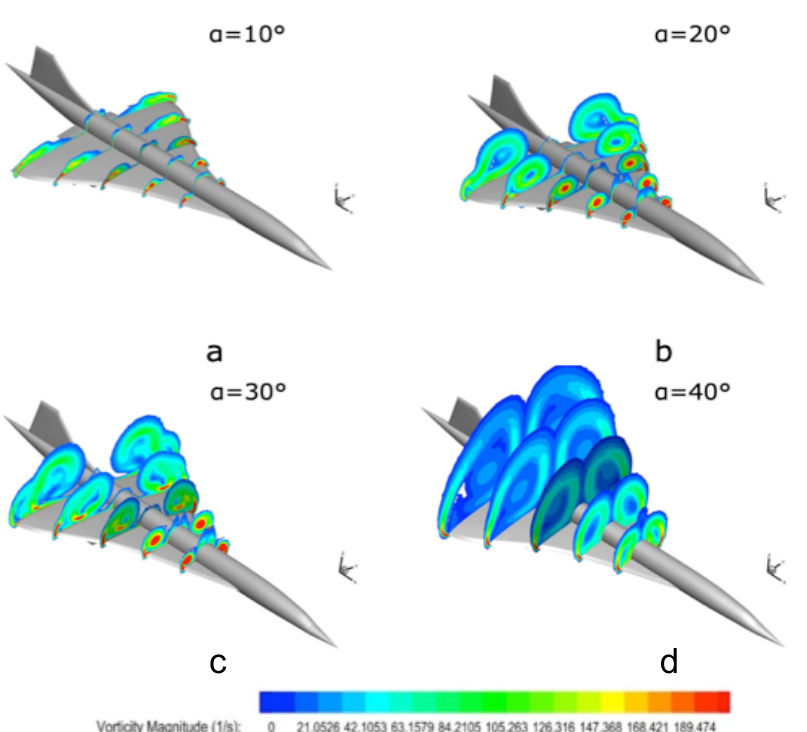
c d Figure 7. Vorticity field on different aircraft cross-sections ( − 45, − 25) m and at different AoAs. ( a ) AoA = 10 ◦ ; ( b ) AoA = 20 ◦ ; ( c ) AoA = 30 ◦ ; ( d ) AoA = 40 ◦